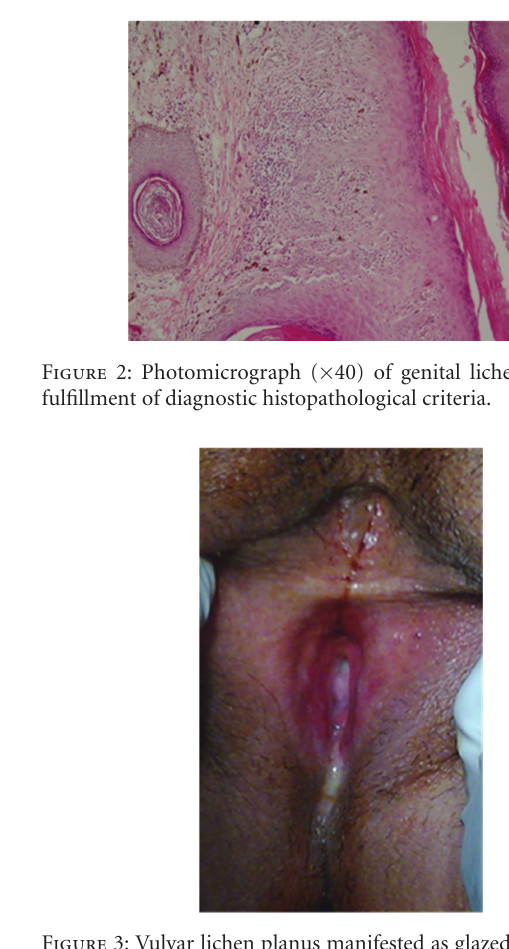
Figure 3: Vulvar lichen planus manifested as glazed erythema and erosion of inner aspect of labia majora and labia minora around the vaginal orifice with associated atrophy, scarring, synechia, and stenosis of vagina leading to pain and